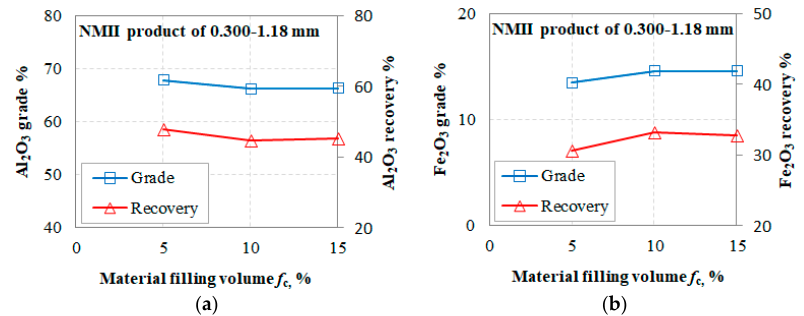
Figure 11. Effect of material filling volume f c on ( a ) Al 2 O 3 grade and recovery and ( b ) Fe 2 O 3 grade and recovery in the NMII product when the 0.300–1.18 mm fraction was subjected to magnetic separation.